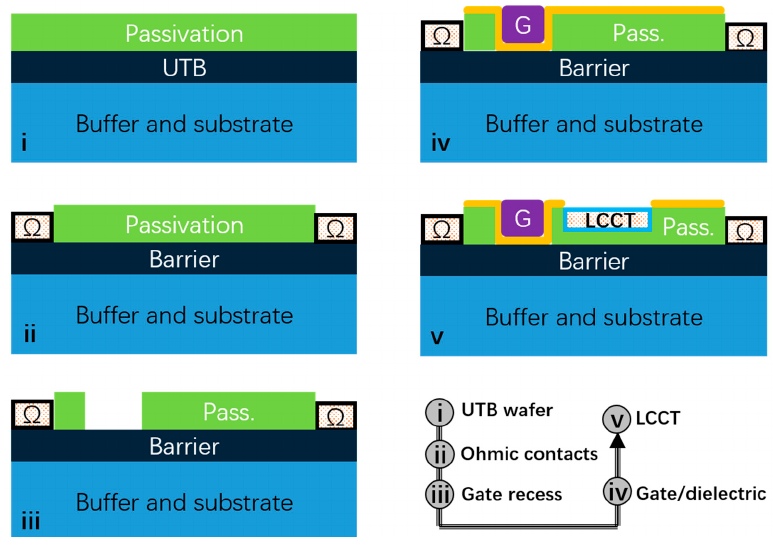
Figure 2. The E-field distribution along the channel in LCCT-HEMT when the drain voltage is 800 V.